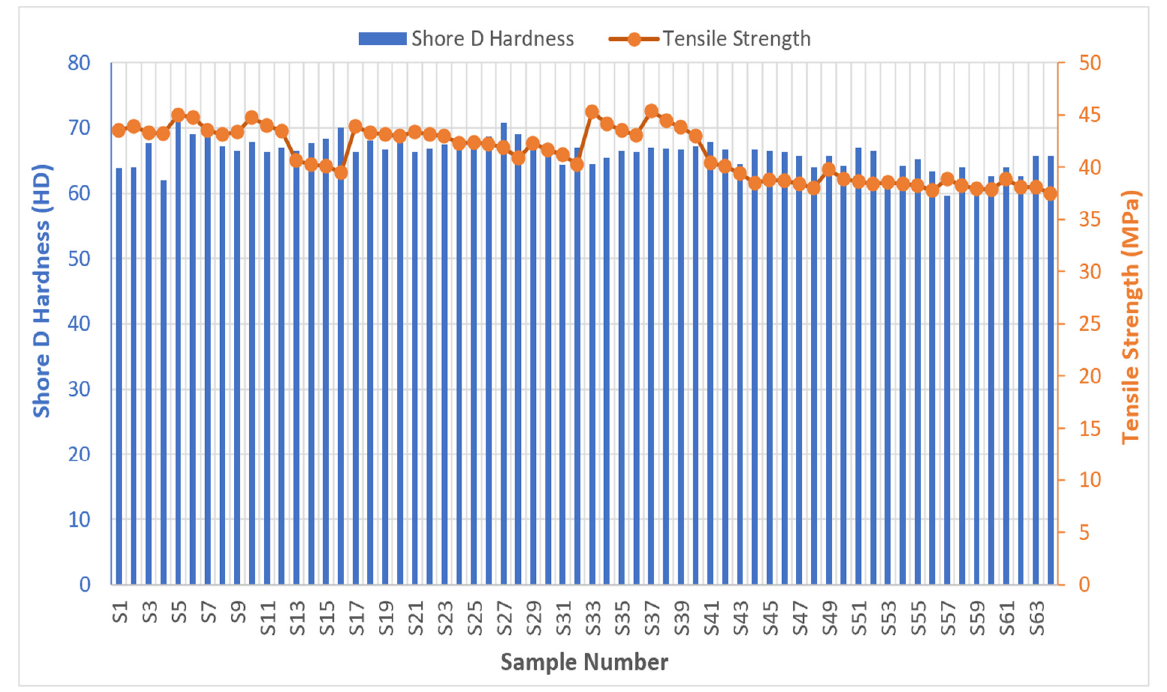
Figure 8. Correlation between hardness and tensile strength.